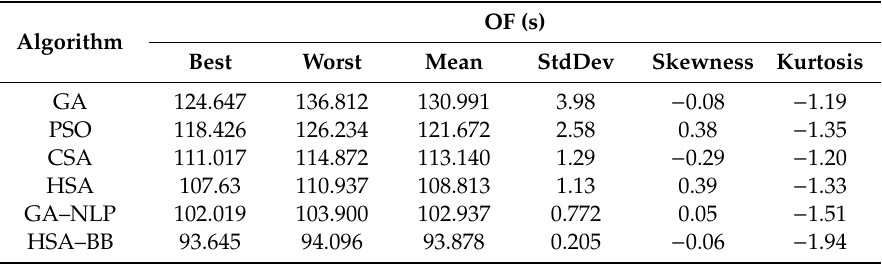
Table 12. Descriptive statistical results based on 50 runs for IEEE 30-bus network.